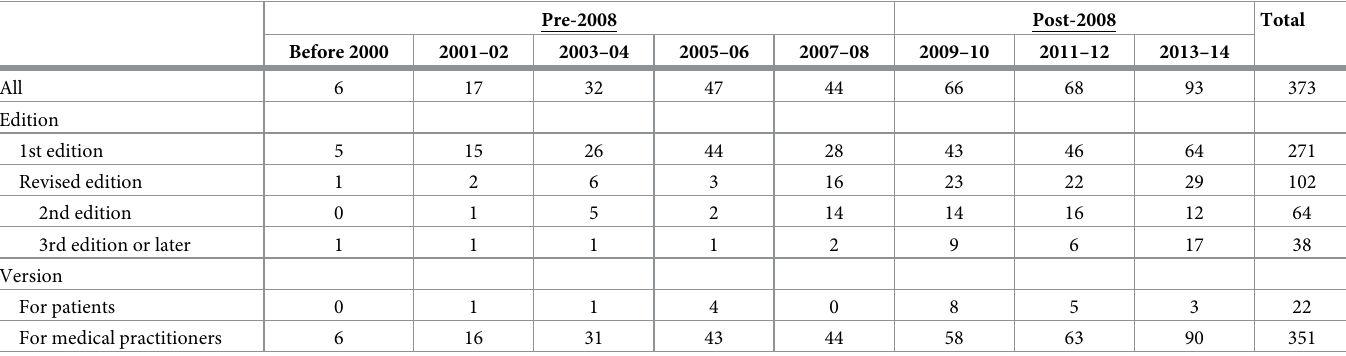
Table 1. Characteristics of evaluated clinical practice